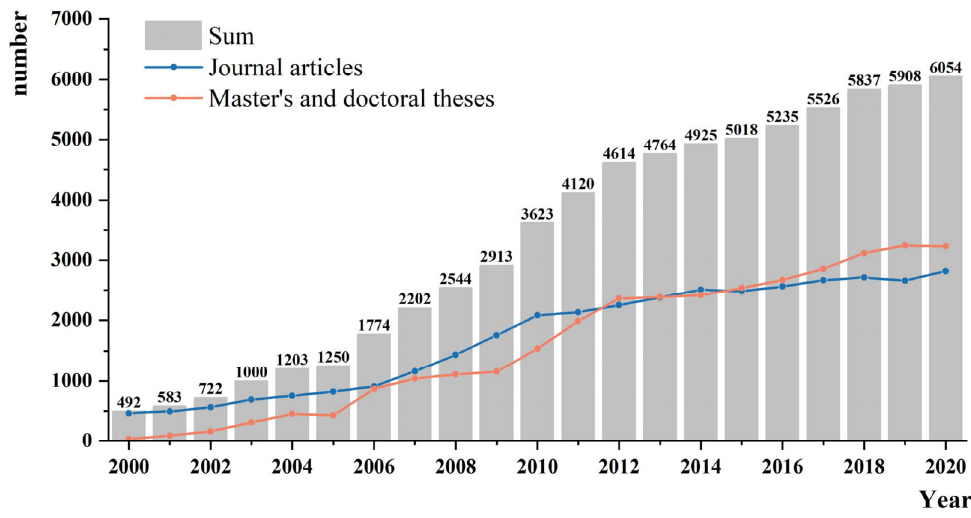
Figure 2. Growth in the number of articles on the impact of climate change over the past two decades. Aiming to identify the climate change hotspots, we extracted the geolocations of more than 70,000 studies on the impacts of climate change and mapped them into grids with a resolution of 50 km × 50 km (Figure 3). Our results show that more than one ‐ third (36.09%) of China’s land area has been studied for at least one aspect of climate change. However, the number of relevant studies in each province varied greatly. We divided the number of samples in each grid cell into nine levels. Specifically, a few scattered studies have been conducted in western and northern China, whereas sampling in eastern coastal China and southern China covered almost all the grid cells in these regions. Note that the white cells do not indicate the lack of an impact of climate change but, rather, areas where no publications were detected within those grids during the study period. However, in this study, the larger number of samples on the impact of climate change in one cell grid suggests a greater impact in that grid, at a regional scale.